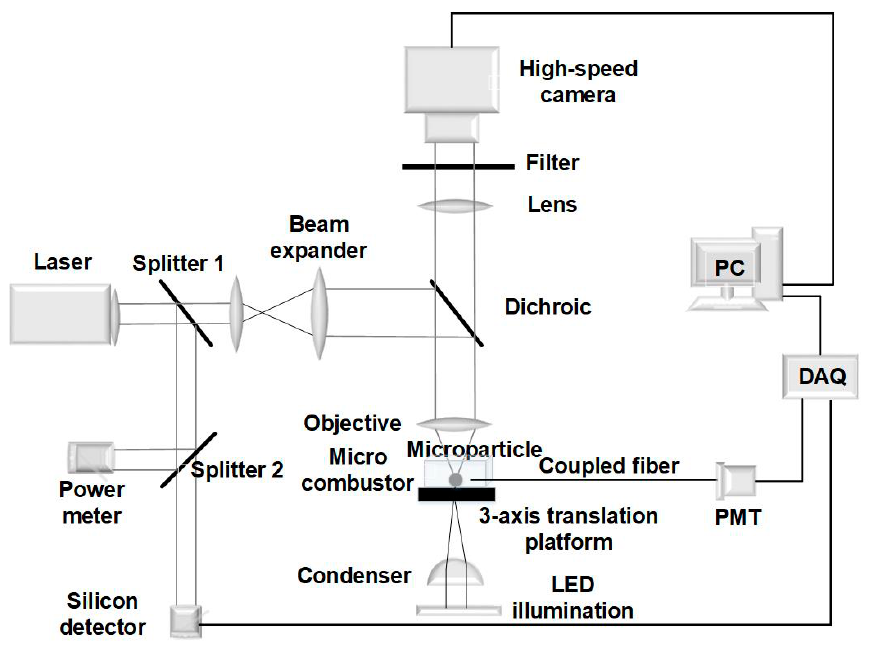
Figure 4. Experimental setup.